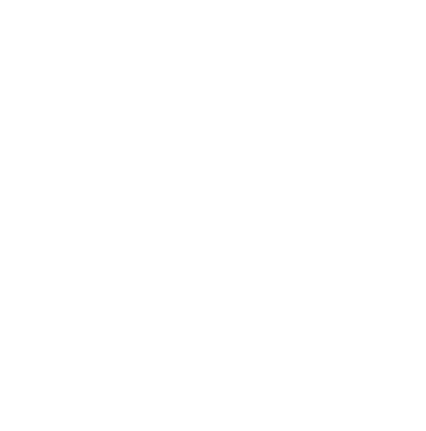
Figure 2. The pseudorange bias extraction result from the C39 satellite, as obtained by the type B receiver.